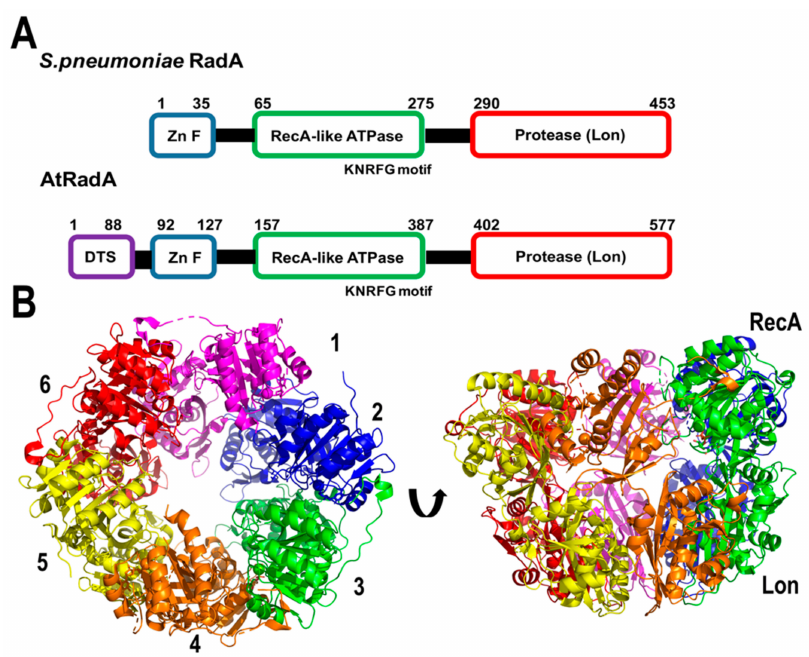
Figure 7. Plant RadA resembles the bacterial enzyme. ( A ) Structural organization of AtRadA in comparision to bacterial RadA. AtRadA shares 63% amino acid similarity with RadA from S. pneumoniae and complete amino acid identity in the catalytic amino acids. Bacterial RadA harbor a zinc finger (ZnF), a Rec-A like ATPase domain with a unique KNRFG motif, and a region homologous to the Lon protease. ( B ) Crystal structure of the Rec-A like ATPase and Lon protease domains of RadA from S. pneumoniae showing its resemblance to a hexameric helicase. The ZnF domain is not present in the crystal